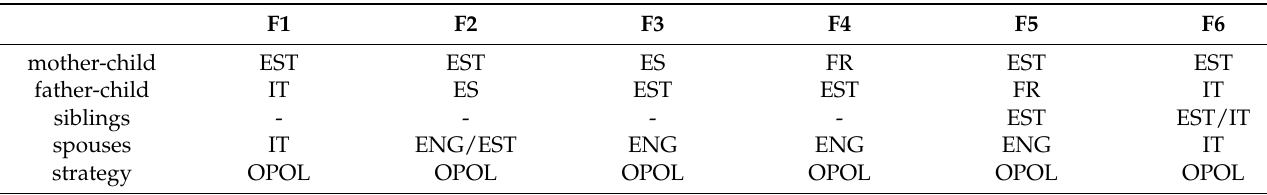
Table 3. Languages spoken among family